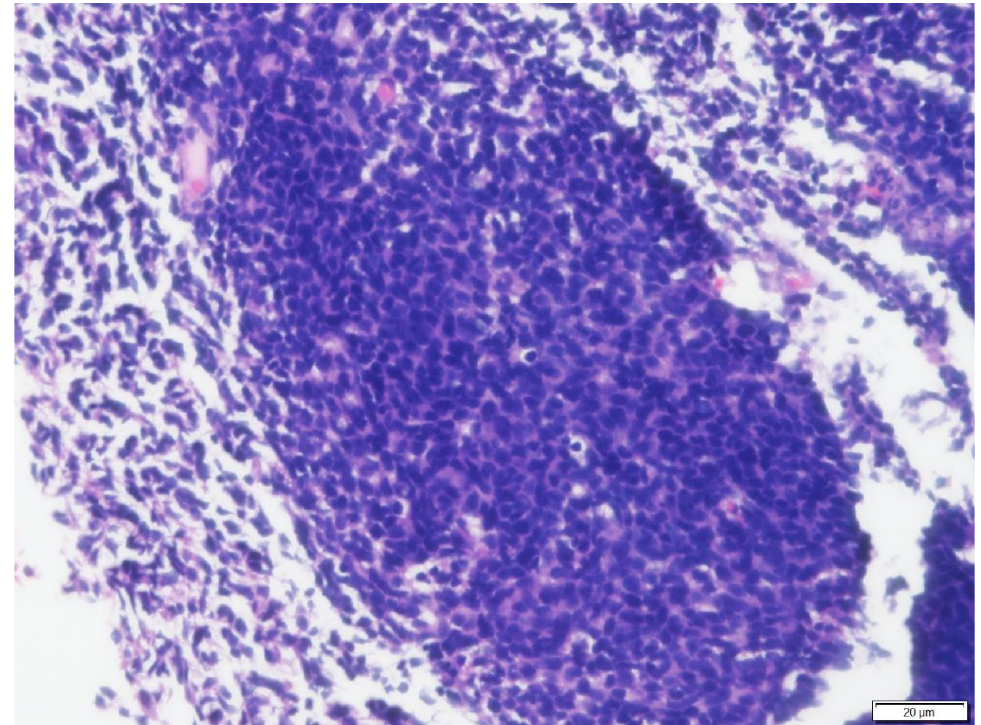
Figure 5. Higher magnification of the dense infiltrate in Case N.2. The large lymphocytes were round, with minimal cytoplasm, a round to oval nucleus, hyperchromatic chromatin and inconspicuous nucleolus. H&E stain (400× magnification).